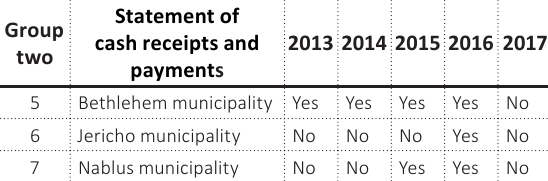
Table 13. Statement of cash receipts and